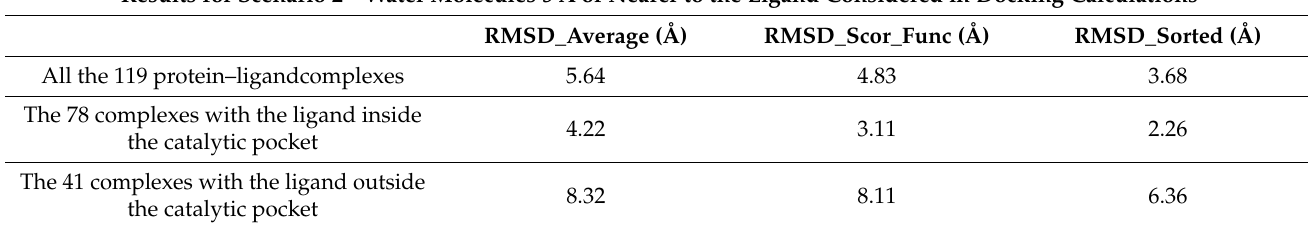
Table 2. Table representing the self-docking results obtained for Scenario 2. Results for Scenario 2—Water Molecules 5 Å or Nearer to the Ligand Considered in Docking